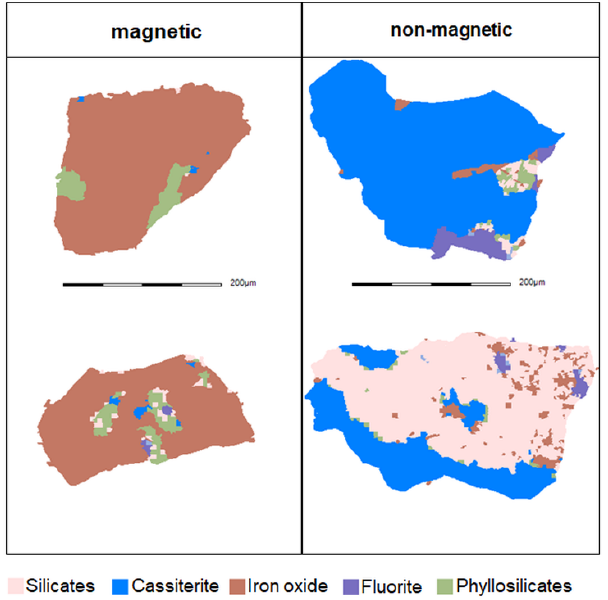
Figure 14. Examples of particle images for particles containing cassiterite and iron oxides in the magnetic and the non-magnetic products.